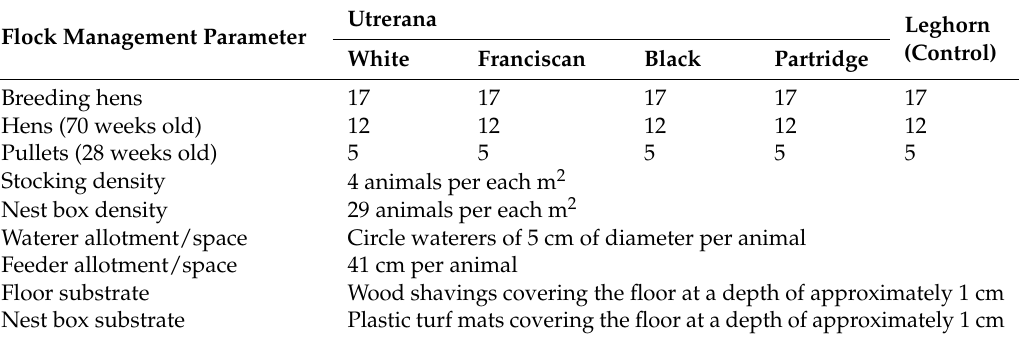
Table 1. Flock management information. All cages were chosen according to Council